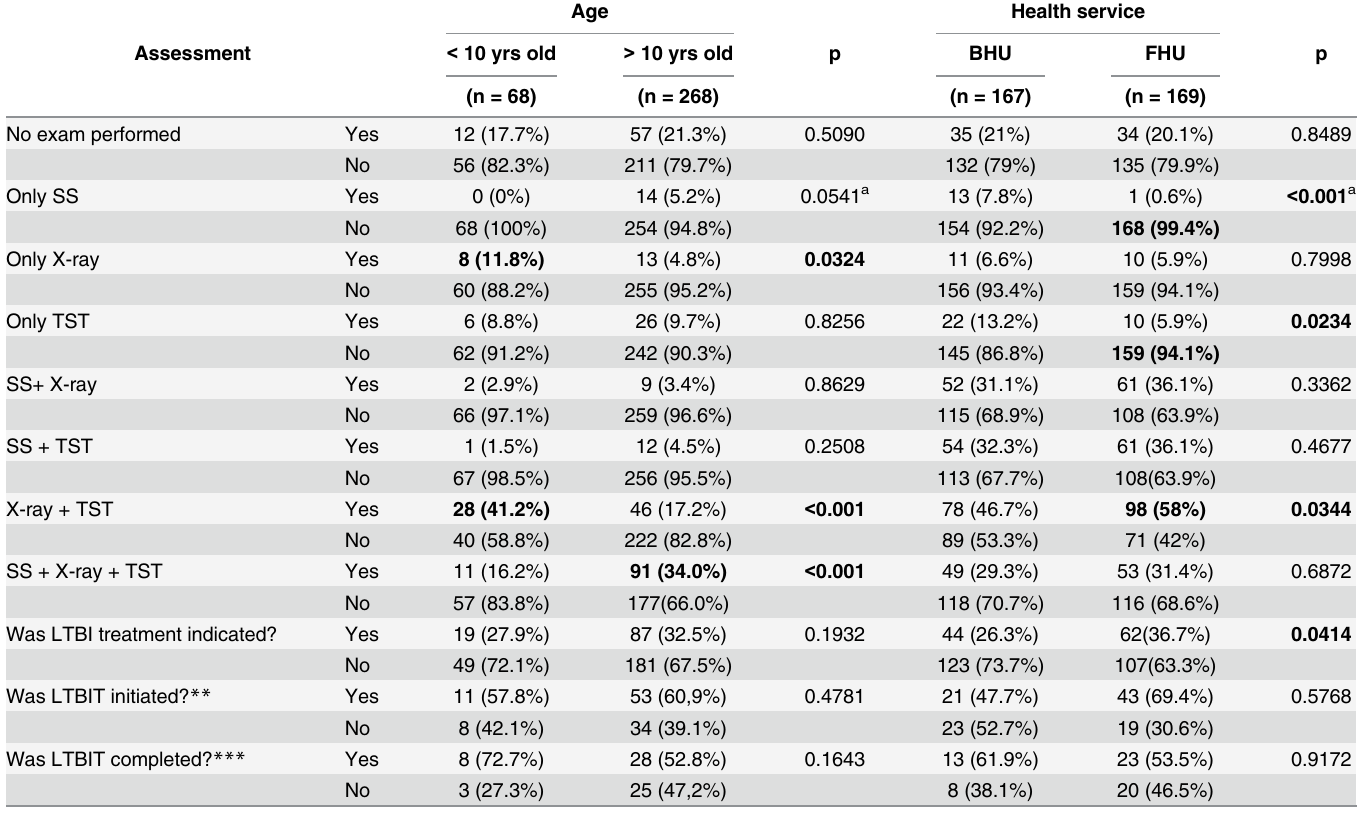
Table 2. Clinical assessment and exams performed for pulmonary TB contacts according to age and PHC service, Sao Jose do Rio Preto-SP, Bra- zil, 2012 –